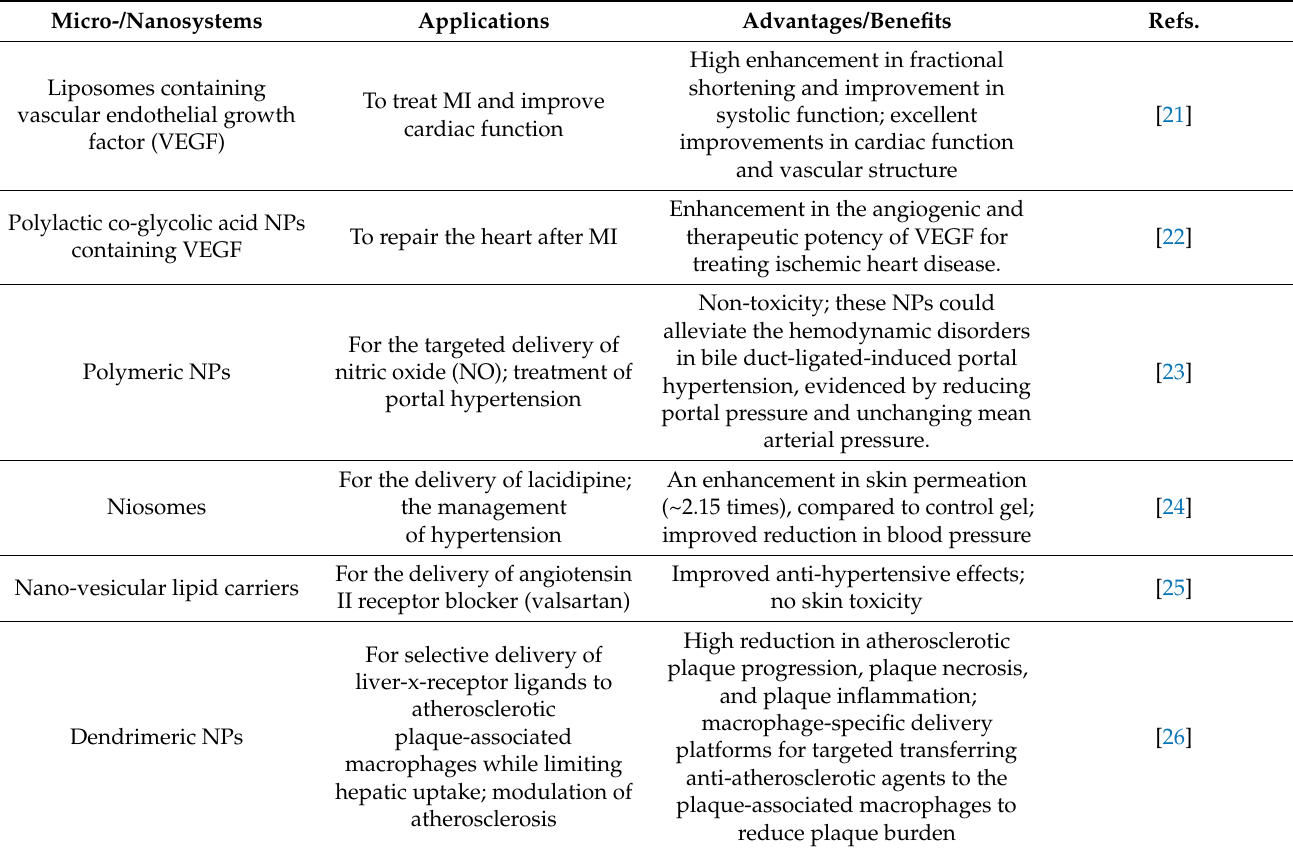
Table 1. Some selected examples of micro-/nanosystems for the treatment of